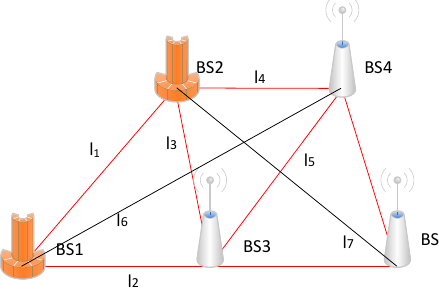
Figure 5. Proximity principle to select neighbor base station.